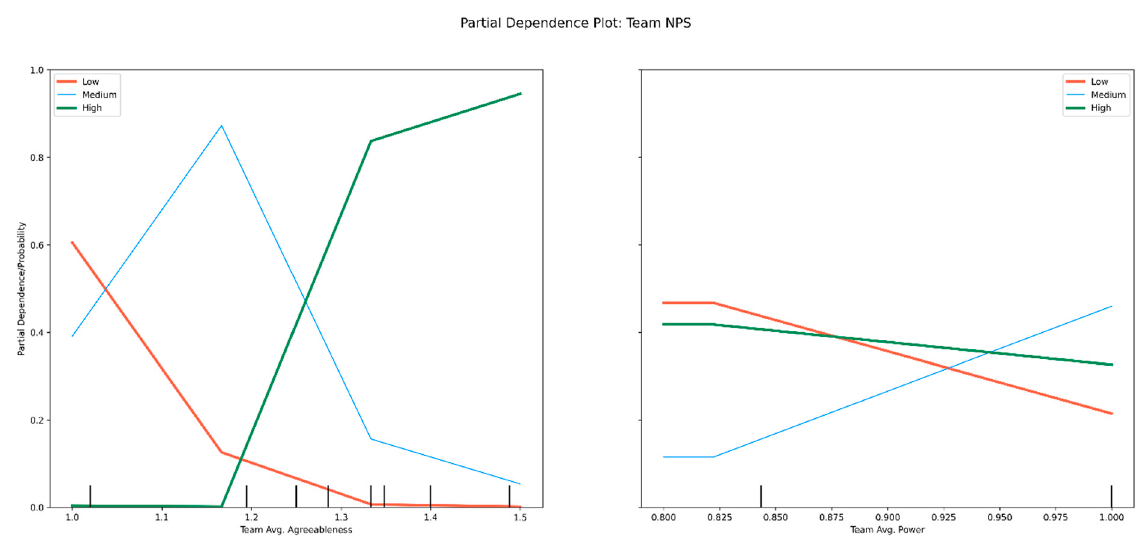
Figure A4. PDP of Team NPS Model.